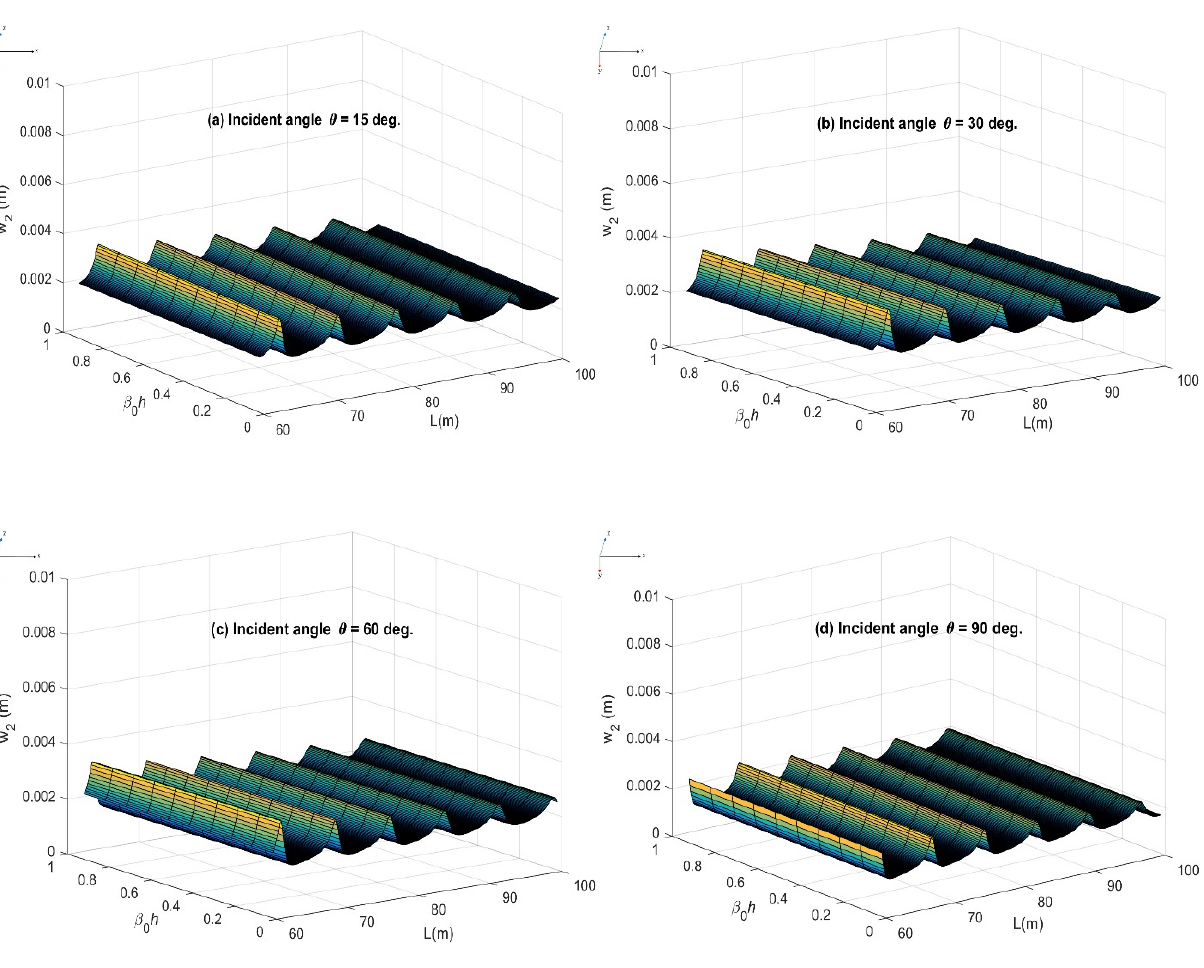
(m) w with a floating flexible plate for different θ with 0.5 i σ= versus Figure 8. Displacement w 2 ( m ) with a floating flexible plate for different θ with σ = 0.5 i versus β 0 h Figure 8. Displacement 2 and L ( m ) h β and (m) L . 0